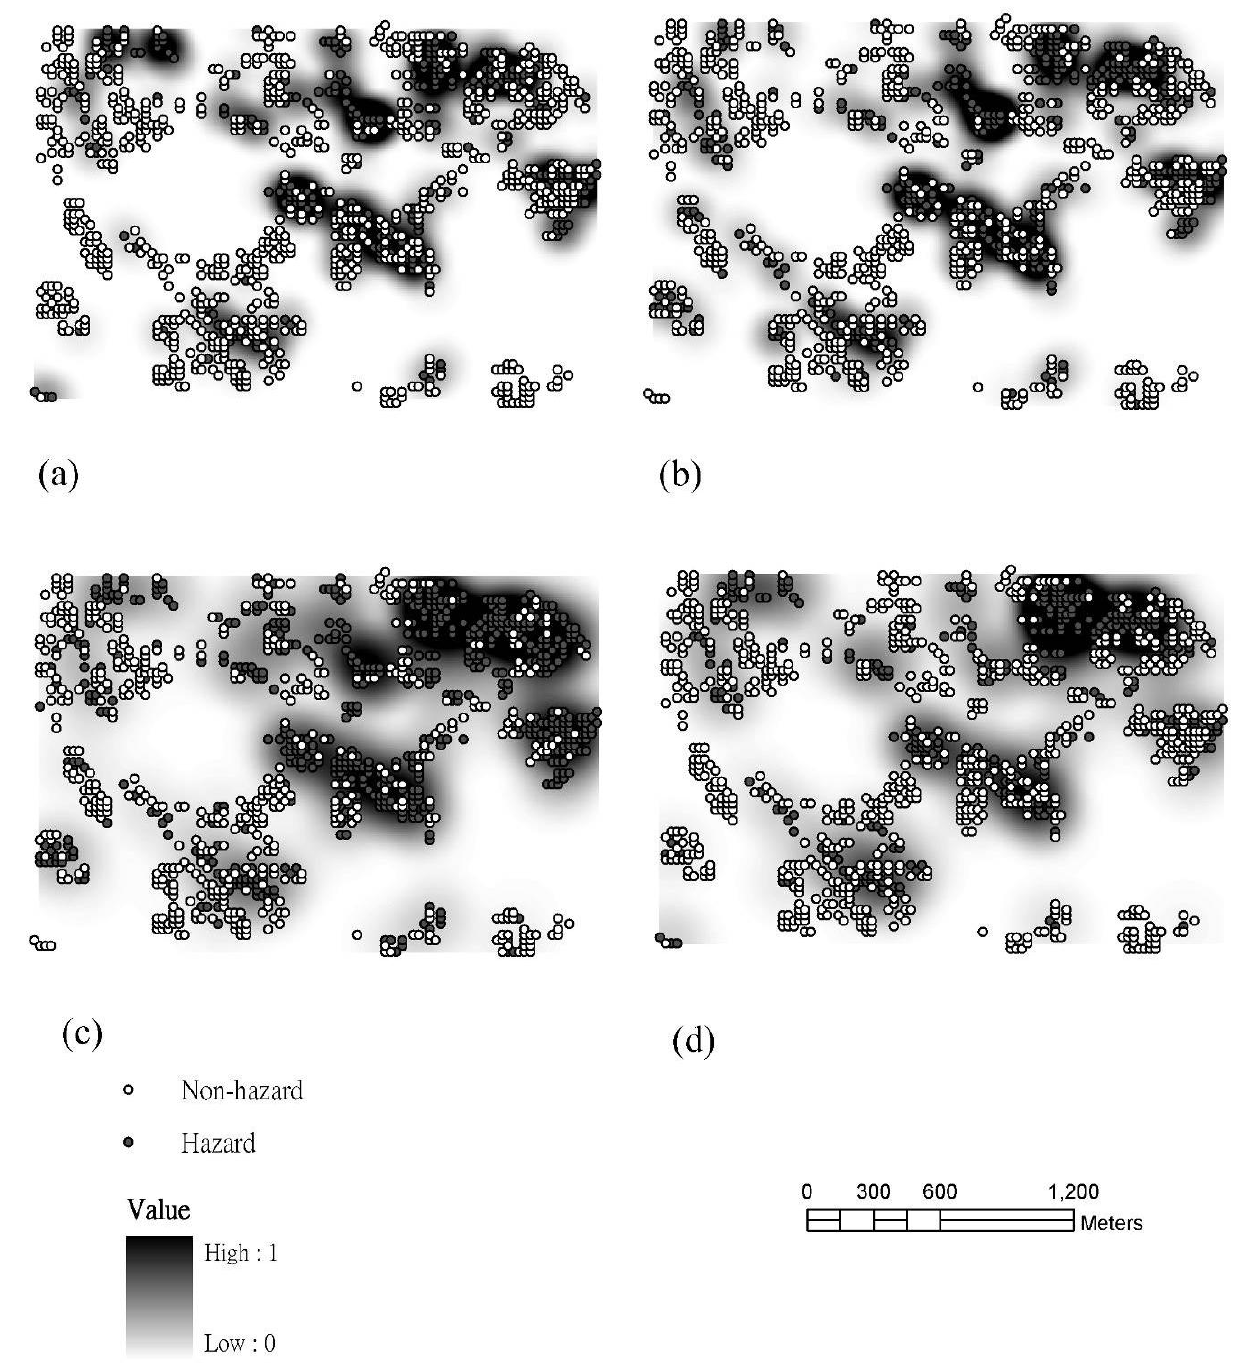
Figure 2. The kernel density maps (stretched to min–max range) of (a) Cr (b) Cu (c) Ni (d)